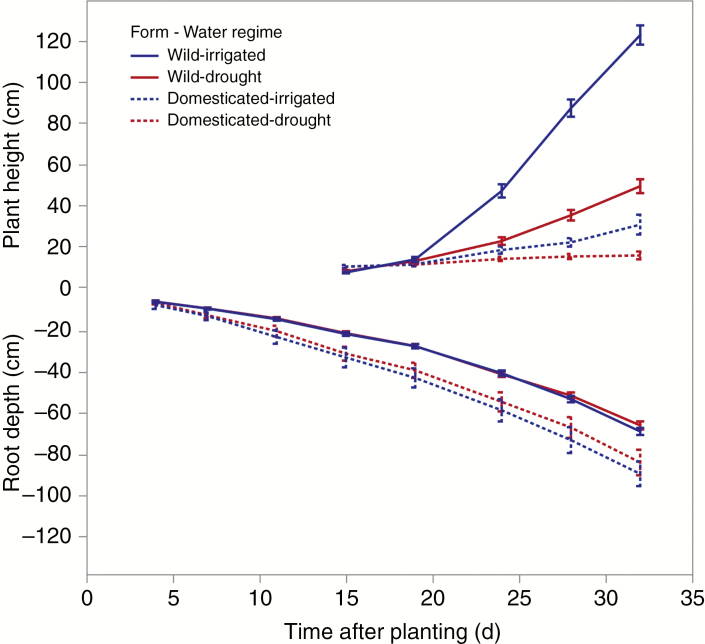
Plant height and visual root depth development. Plant height was measured starting 15 d after planting. The bars show the 95 % confidence interval.